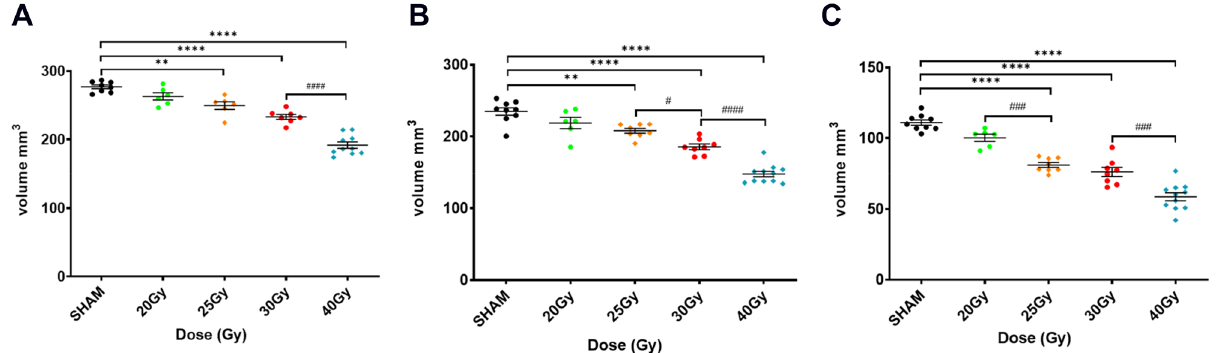
Figure 3. Bone volume quantification according to doses 16 W after irradiation using three CT images. ( A ) Quantification of total mandibular bone volume according to in vivo CT images acquired with a voxel size of 90 µm and ( B ) ex vivo total CT images acquired with a voxel size of 72 µm. ( C ) Bone volume quantification focus on region of interest (ROI) design on ex vivo CT scans (reconstructed voxel size: 25 µm). N = 8 animals for Sham, 25 Gy and 30 Gy; N = 6 animals for 20 Gy; N = 10 animals for 40 Gy. * versus sham; # versus groups. Statistical analysis: Normality tests Shapiro /Kolmogorov then One-way ANOVA.